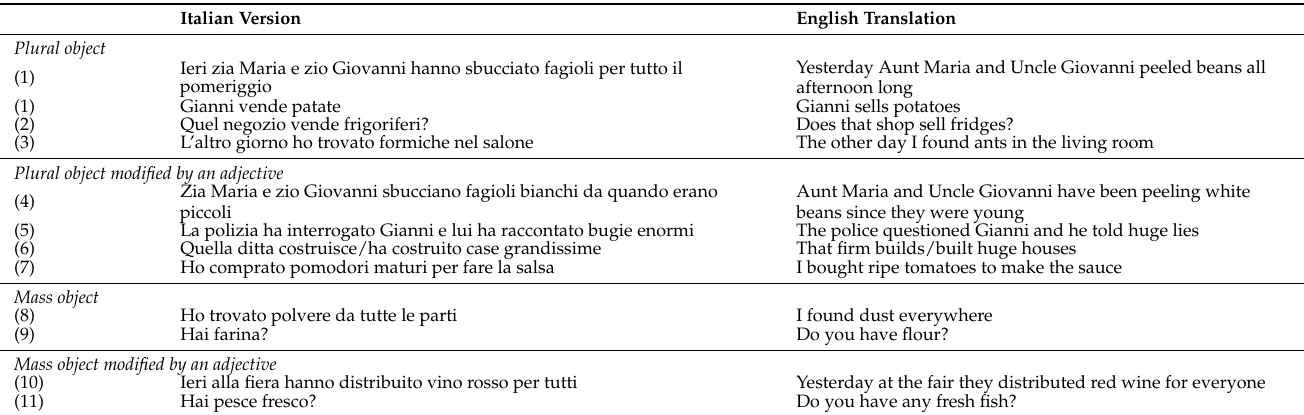
Table A6. Patterns for data collection.